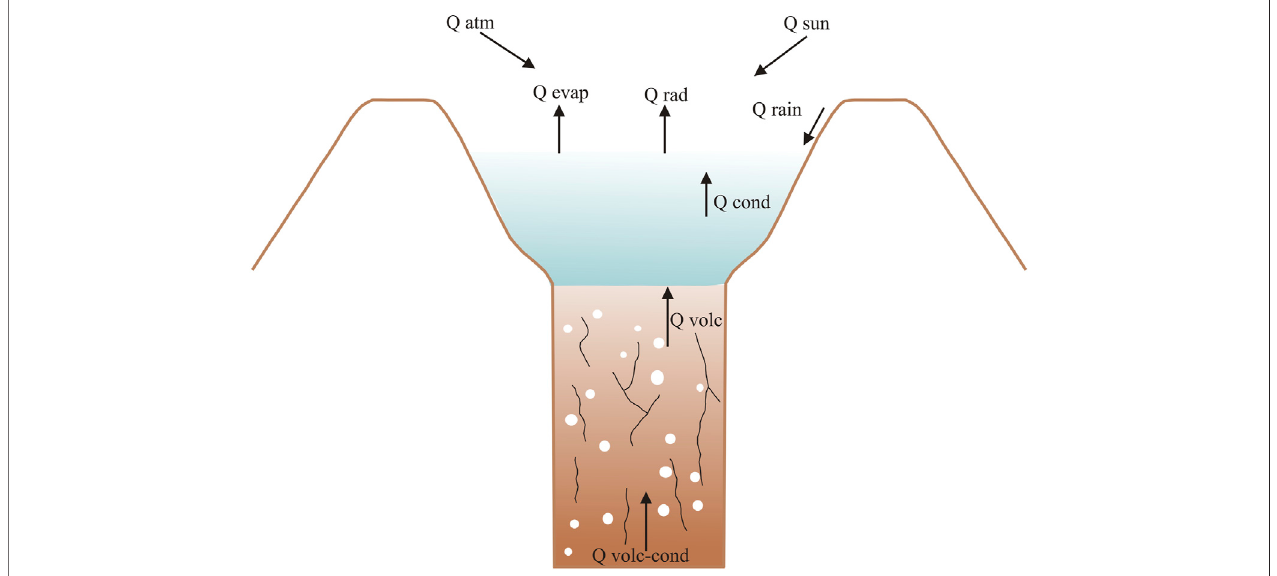
FIGURE 4 | Heat fl uxes involved in the energy balance of a crater lake. Heat fl ux from the sun (Q sun ), atmosphere (Q atm ), radiative (Q rad ), evaporative (Q evap ), conductive (Q cond ), rain water input (Q rain ), conductive heat from a shallow magma body (Q volc-cond ), and volcanic/hydrothermal contribution from the bottom of the lake (Q volc